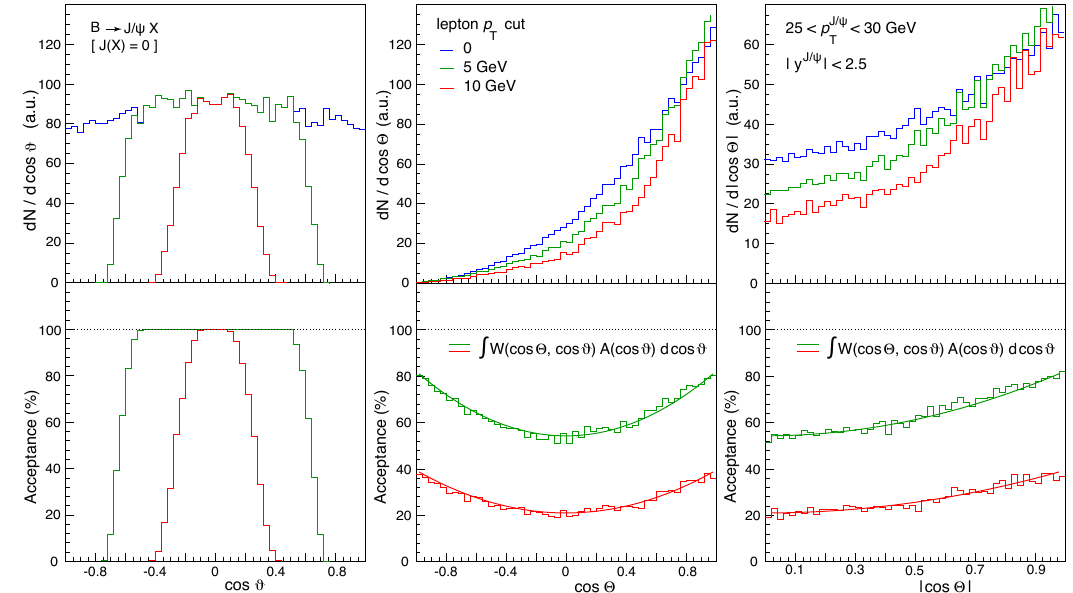
Figure 9 . Top: the cos ϑ (in the J /ψ HX frame, left), cos Θ (in the B HX frame, middle), and | cos Θ | (right) distributions, for simulated B → J /ψ X events with unobserved X and 25 < p J /ψ before (blue) and after (green and red) rejecting events with muon p T smaller than 5 or 10 GeV. The distributions are arbitrarily normalized, to emphasize the shape differences. Bottom: corresponding acceptance ratios, representing the fractions of events surviving the two considered muon selections. See the text for details on the superimposed